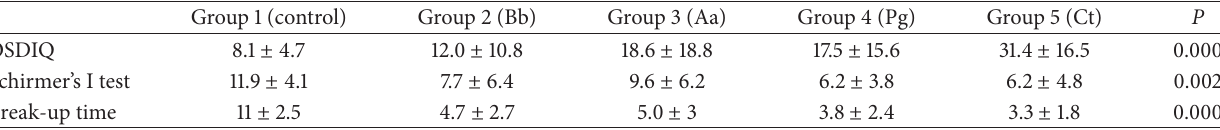
Table 2: Clinical data comparison between control (group 1) and antiglaucoma therapy groups (groups 2, 3, 4, and